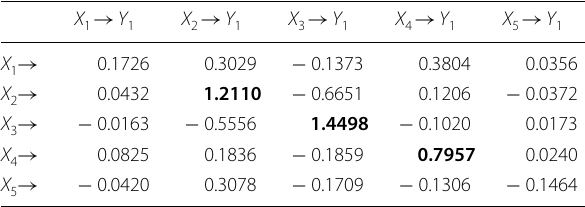
Fig. 1 Basic wood density in relation to stand density and DBH class